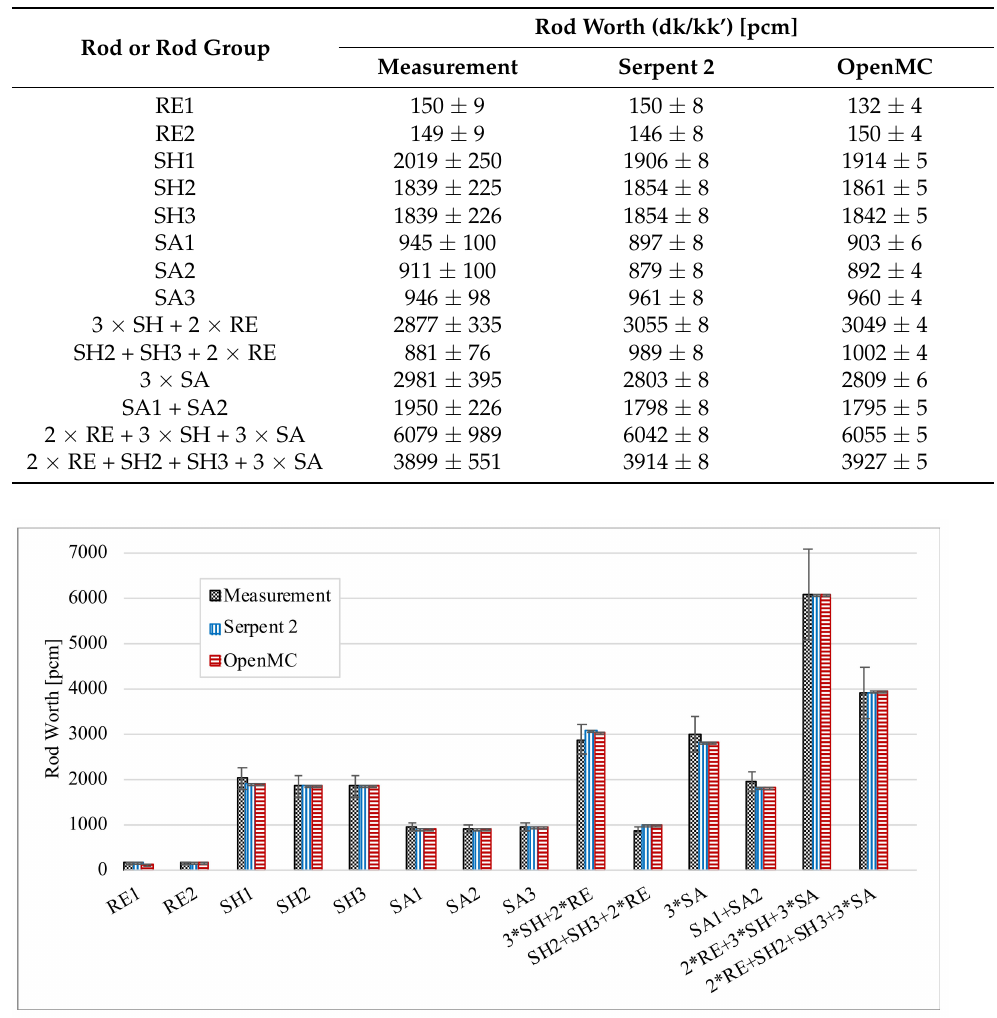
Figure 4. Comparisons of Control-Rod Worths. i.e., RE2 means regulating rod No. 2, and 2 × RE means two regulating rods; RE1 and